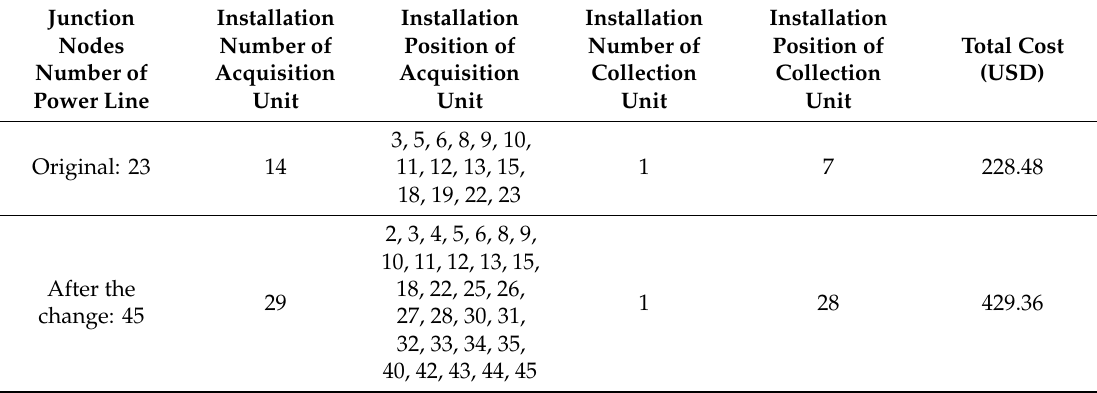
Table 5. Optimal placement of fault indicators under di ff erent junction nodes of the power line.